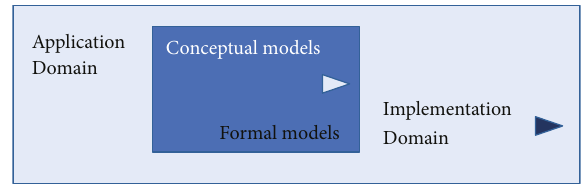
Figure 3: The essential software process